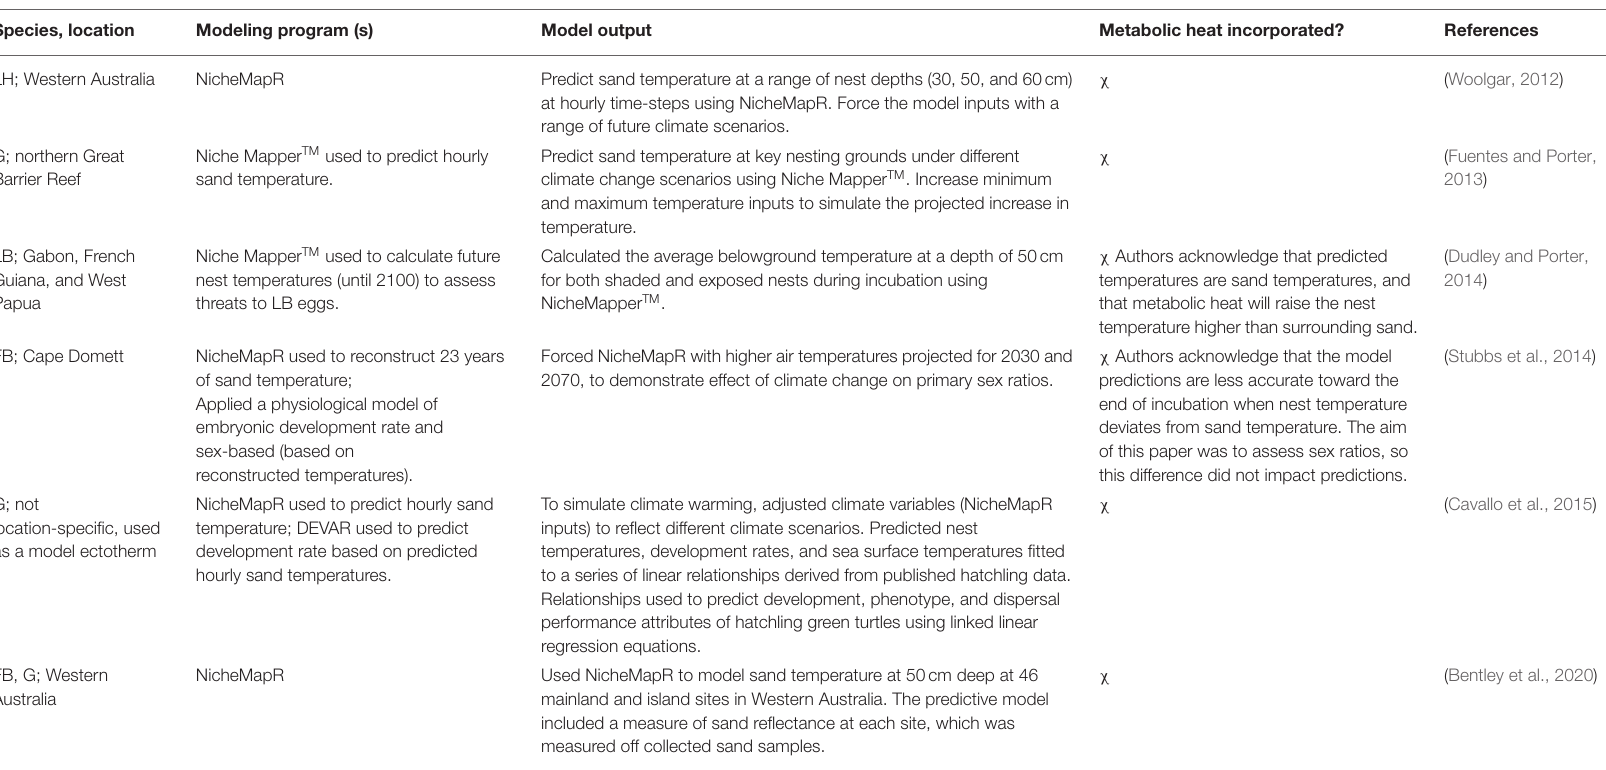
TABLE 2 | An overview of all studies that used the mechanistic NicheMapR modeling platform to predict the temperature of sea turtle nests, or sand temperature on nesting beaches, shown in chronological order. Species,